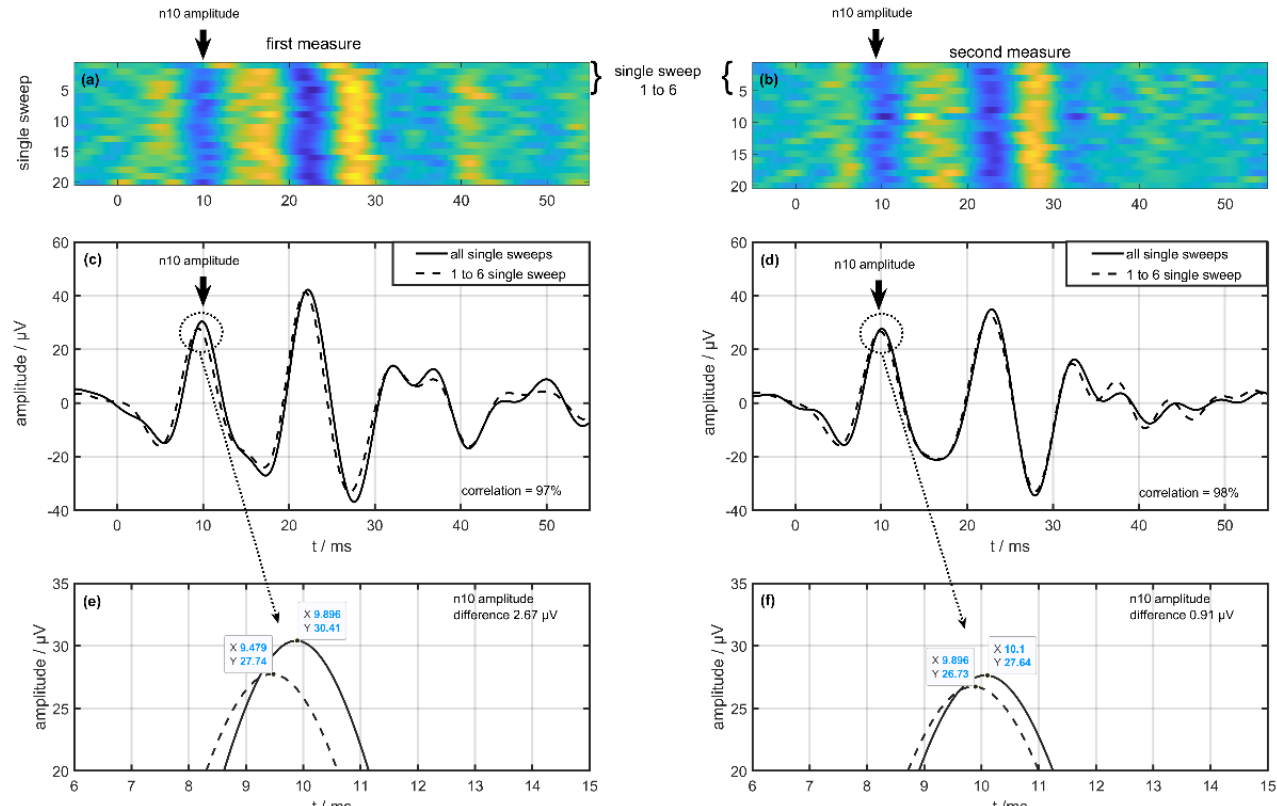
Figure 1. Difference from one volunteer on a single-sweep algorithm between the first (left column) and second measurements (right column) during one examination. ( a , b ) show the single sweeps with a color map on the amplitude and ( c , d ) show the result of averaging the single sweeps (dotted line 1 to 6 single sweep, solid line all single sweeps). The bottom row ( e , f ) shows a view from the n10 amplitude of the averaged signal.